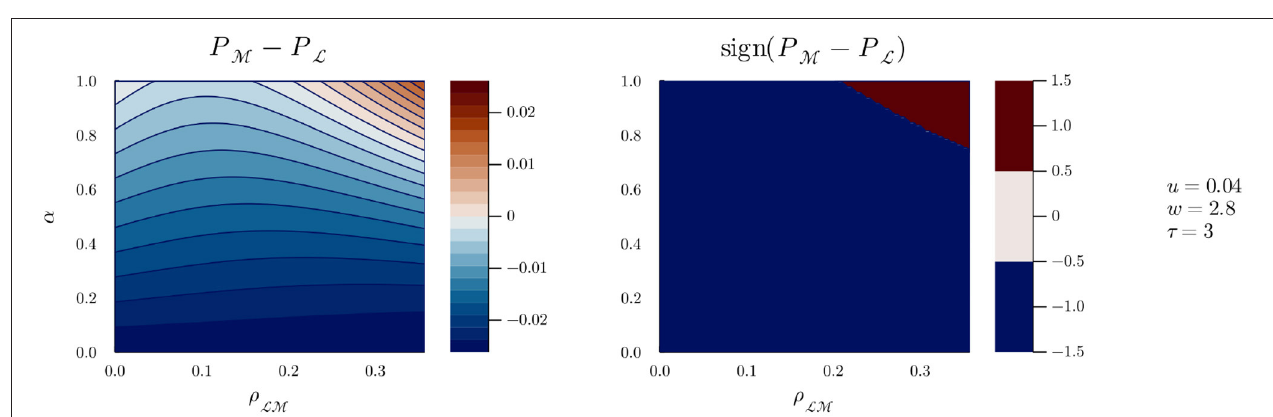
Frontiers in Psychology |